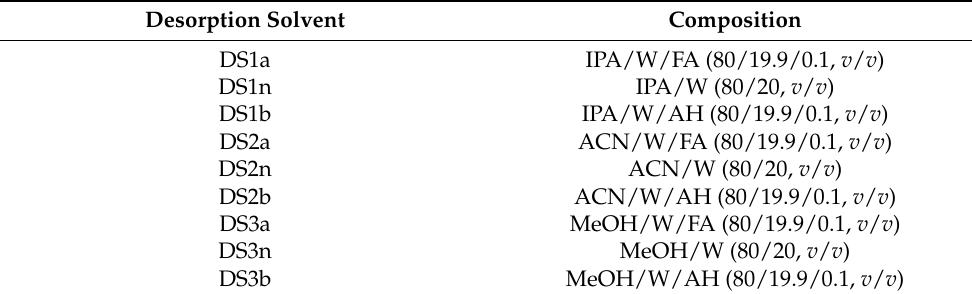
Table 4. Composition of desorption